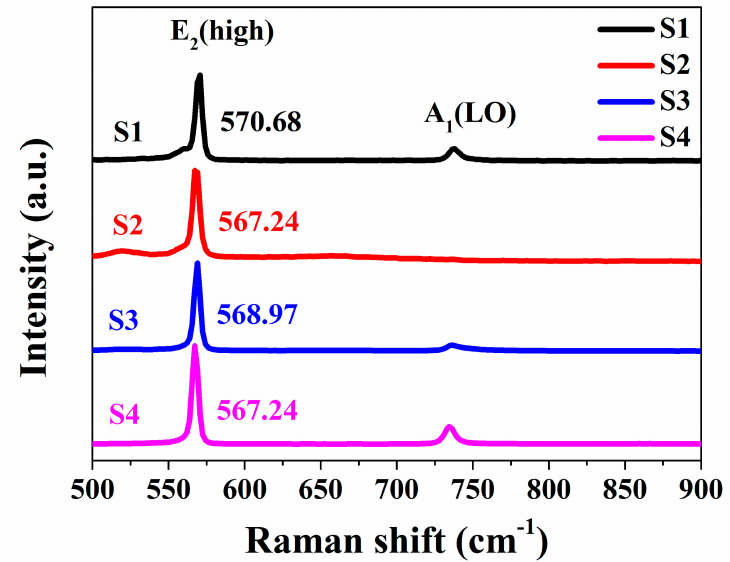
Figure 4. Raman spectra of GaN grown by HVPE for S1, S2, S3, and